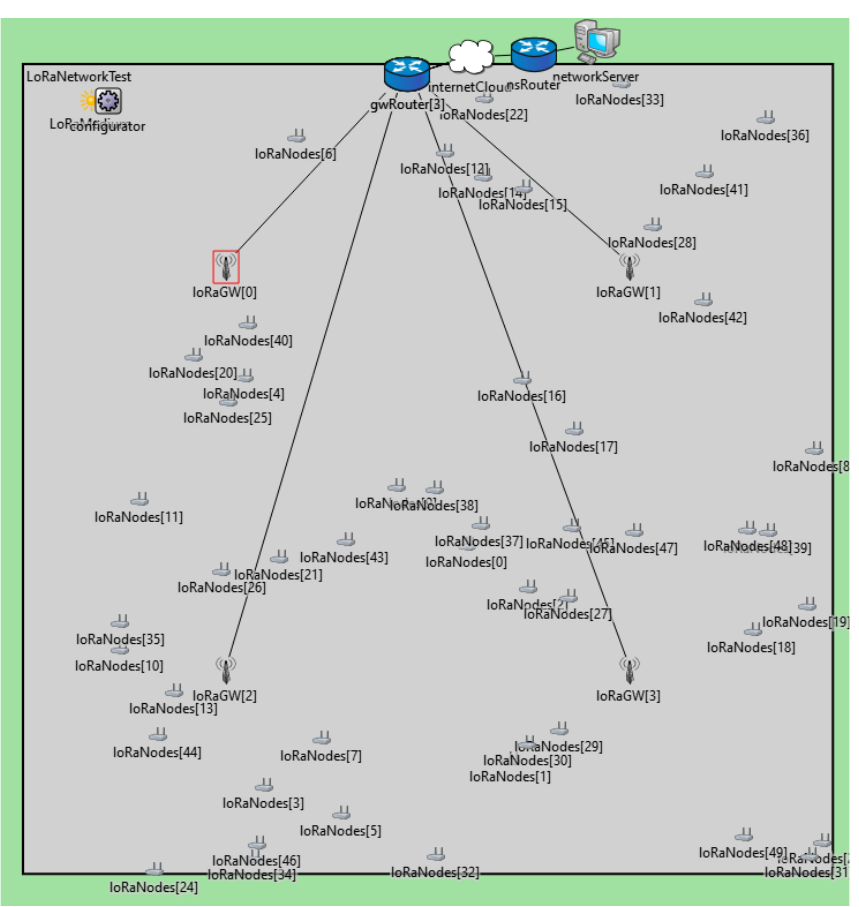
Figure 1. Large network layout and gateway distributions.